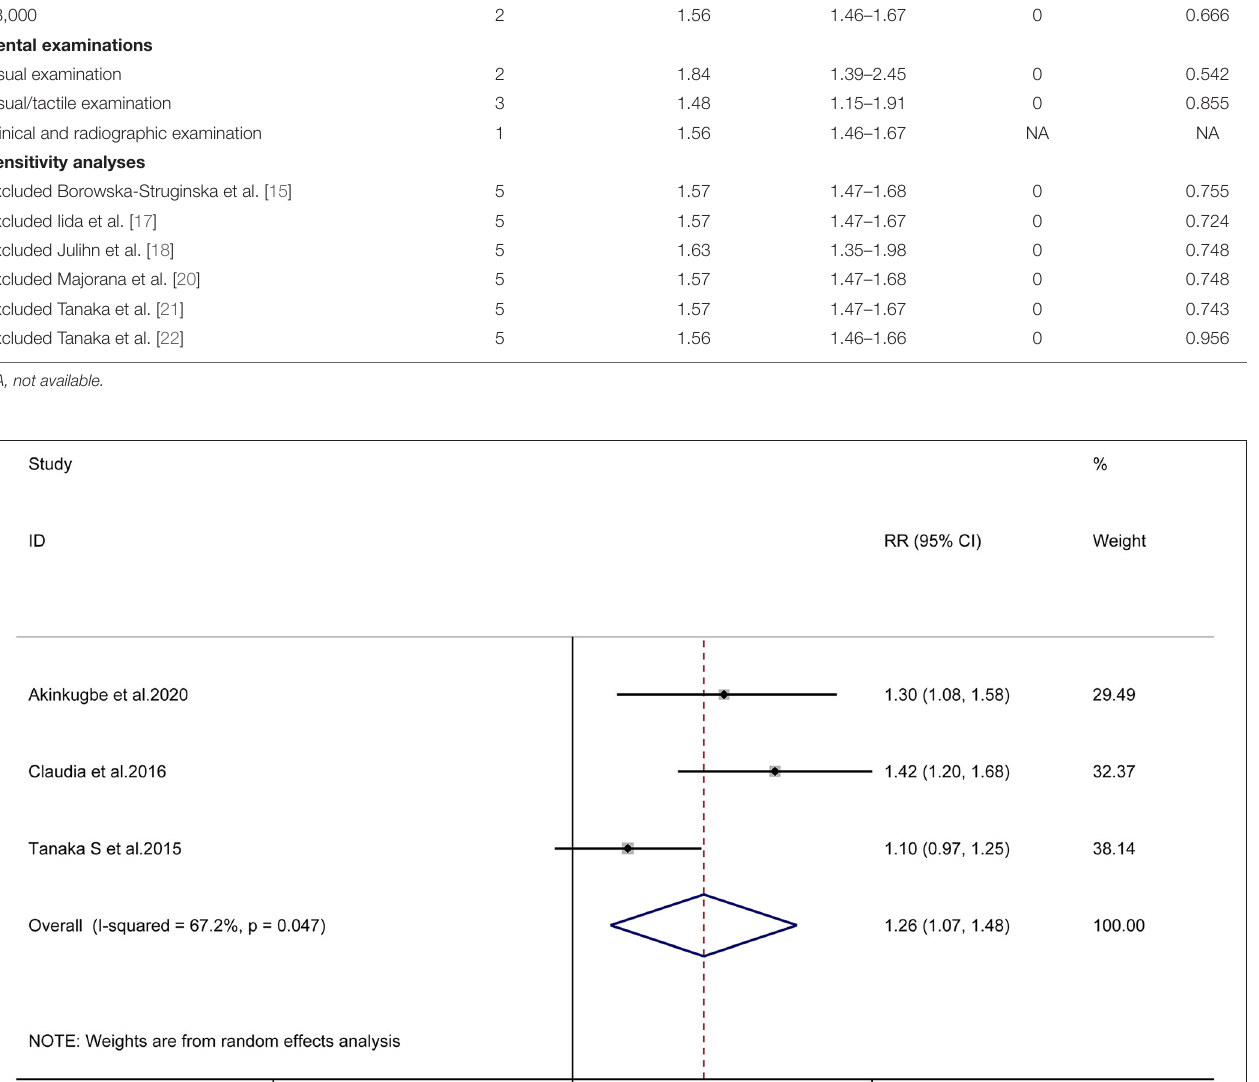
Frontiers in Oral Health |